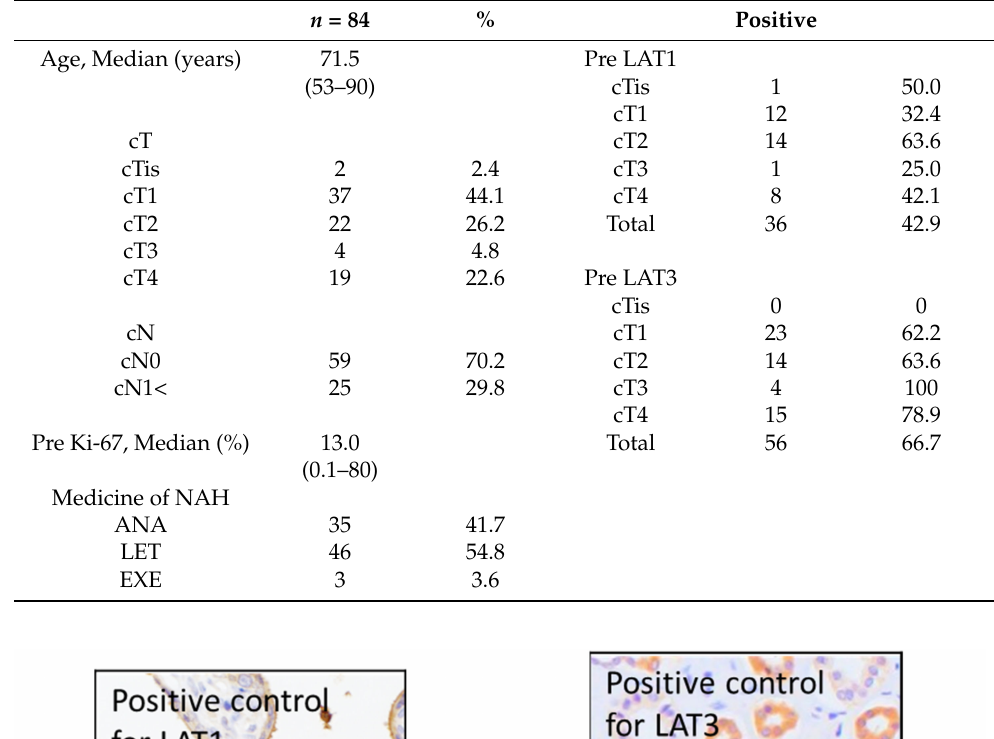
Table 2. Clinicopathological characteristics of breast cancer patients with hormone therapy prior to surgery (Cohort